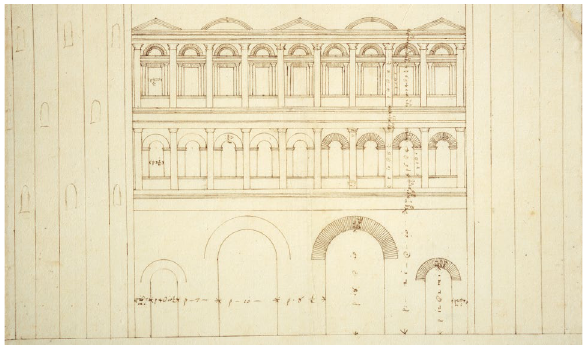
Figure 2 . Andrea Palladio. RIBA31826, 1566. © RIBA